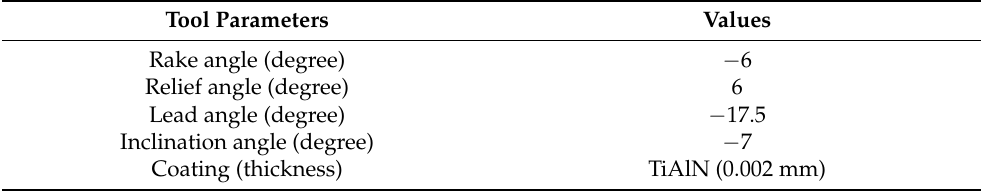
Table 2. The tool geometry used in turning simulations and